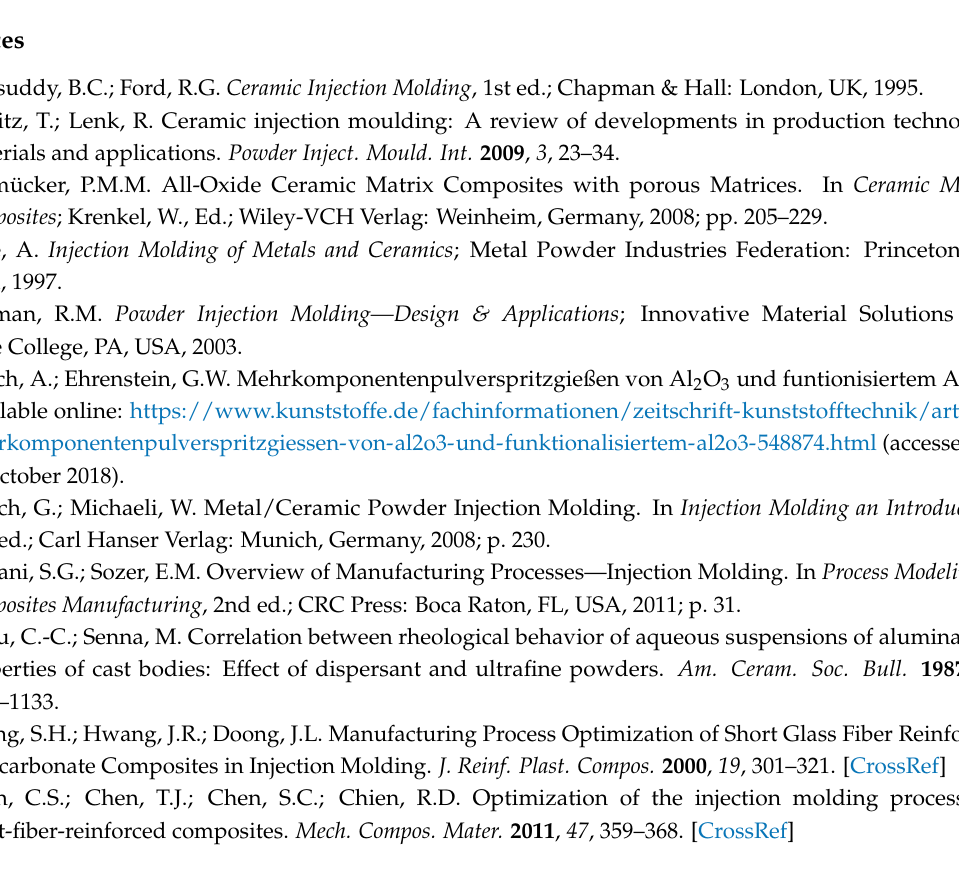
Figure A4. Reproducibility of different feedstocks with different binders and increasing amount of fibers.